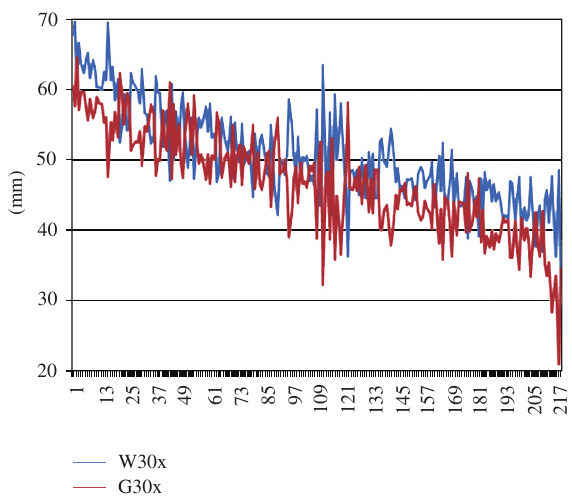
FIGURE 6: Mean stalk length of G30x and W30x seedlings by dish pair in the autumn experiments (A1 through A9), with dish pairs ordered according to their joint mean stalk length. Red line: curve connect- ing G30x values; blue line: curve connecting W30x values; ordinate: mm; abscissa: dish pairs ordered according to their joint mean stalk length. For further explanations see text.